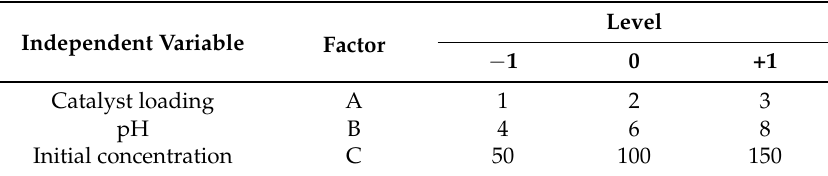
Table 9. Factors and their